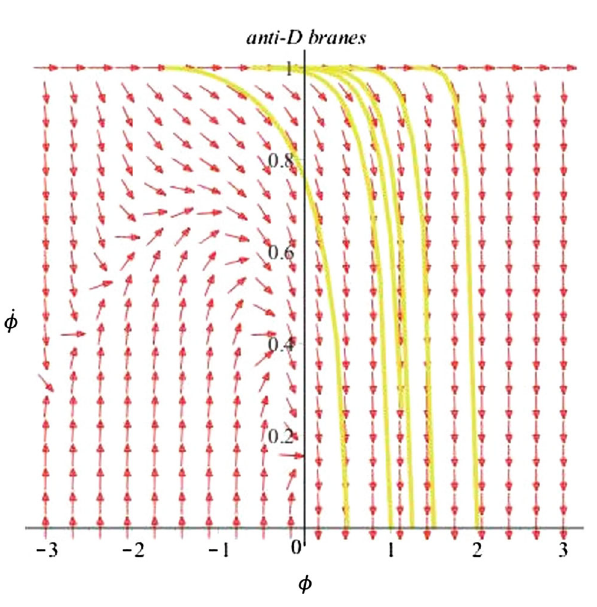
Fig. 2 Phasespacediagramfor V (φ) = V . e 1 2 m 2 φ 2 with V . = 2 and coupling constant f (φ) = 1